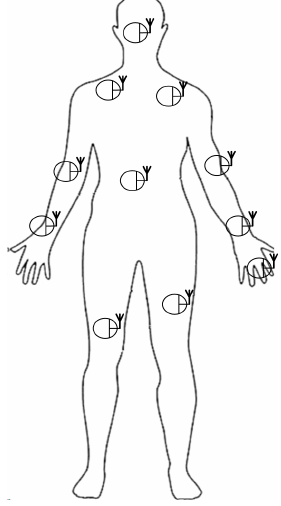
Figure 10. BAN network setup.